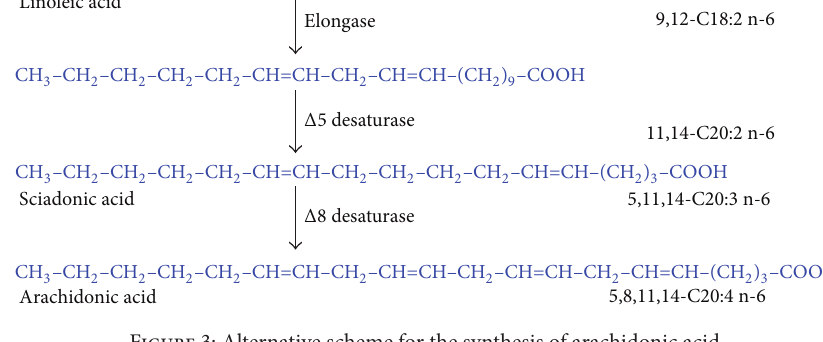
Figure 3: Alternative scheme for the synthesis of arachidonic acid.